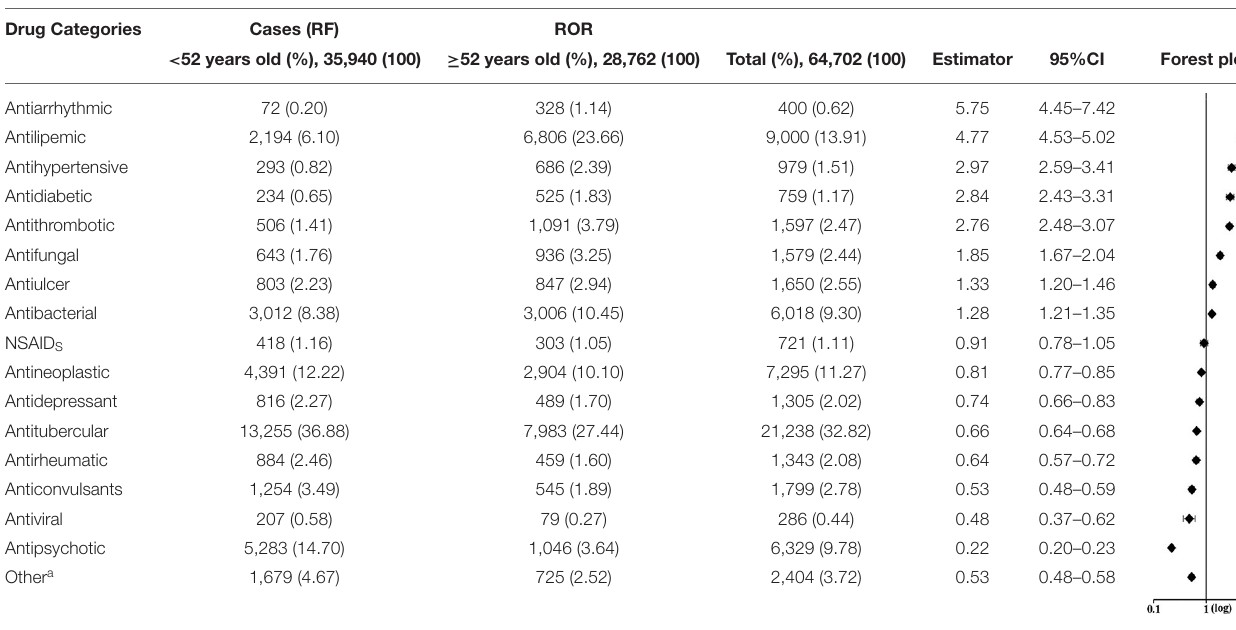
TABLE 1 | ROR for different drug